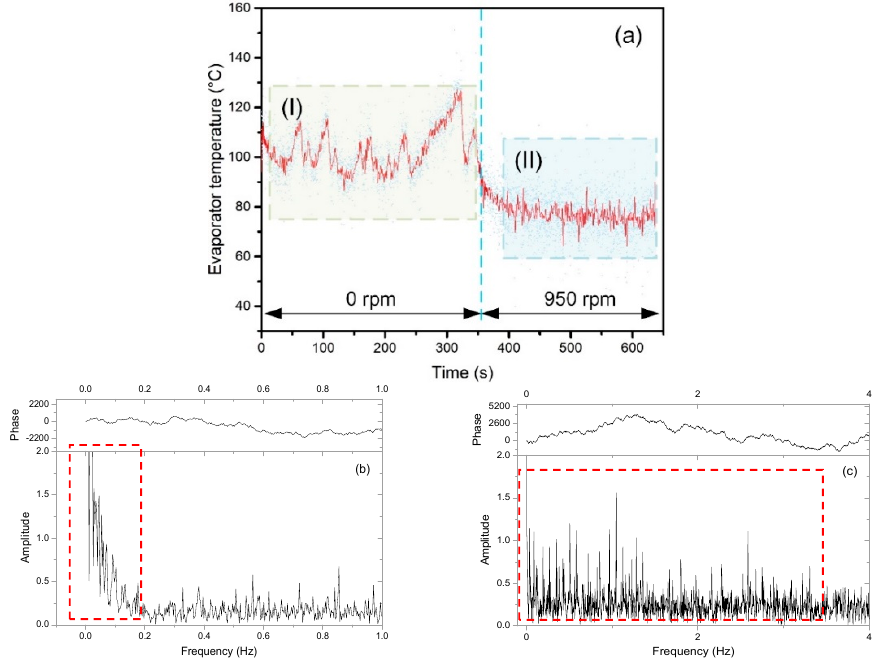
Figure 7. Evaporator temperature under rotational speed of 0 rpm and 950 rpm (filled with methanol): ( a ) temperature curve; and ( b ) and ( c ) FFT analysis of the temperature curve in areas (I) and (II).